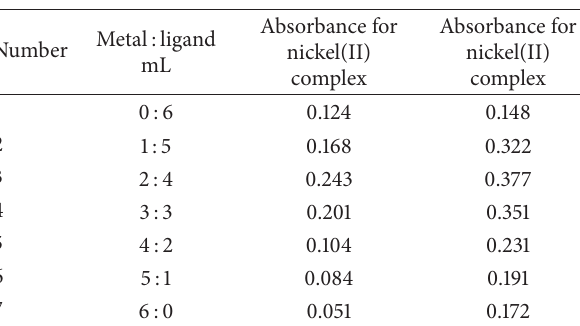
Table 4: Experimental data for nickel(II) and copper(II) extraction by Job’s continuous variation